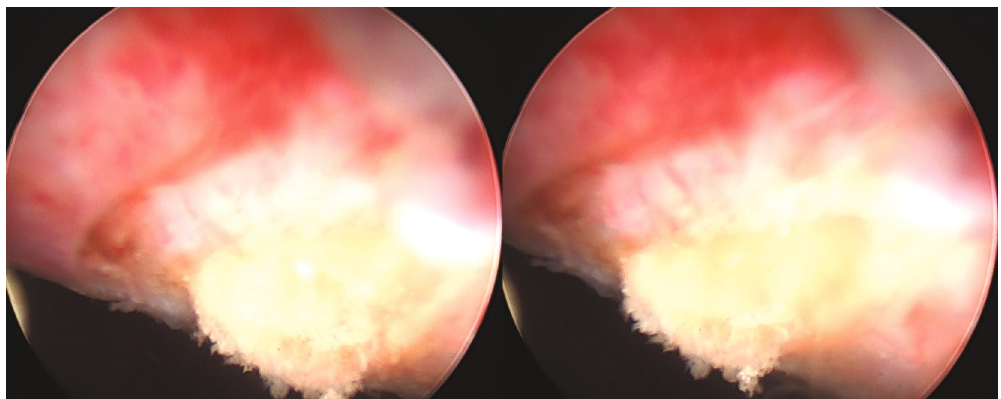
Figure 4: Photos taken during transurethral resection the bladder mass showing yellow, purulent fl uid indicative of an